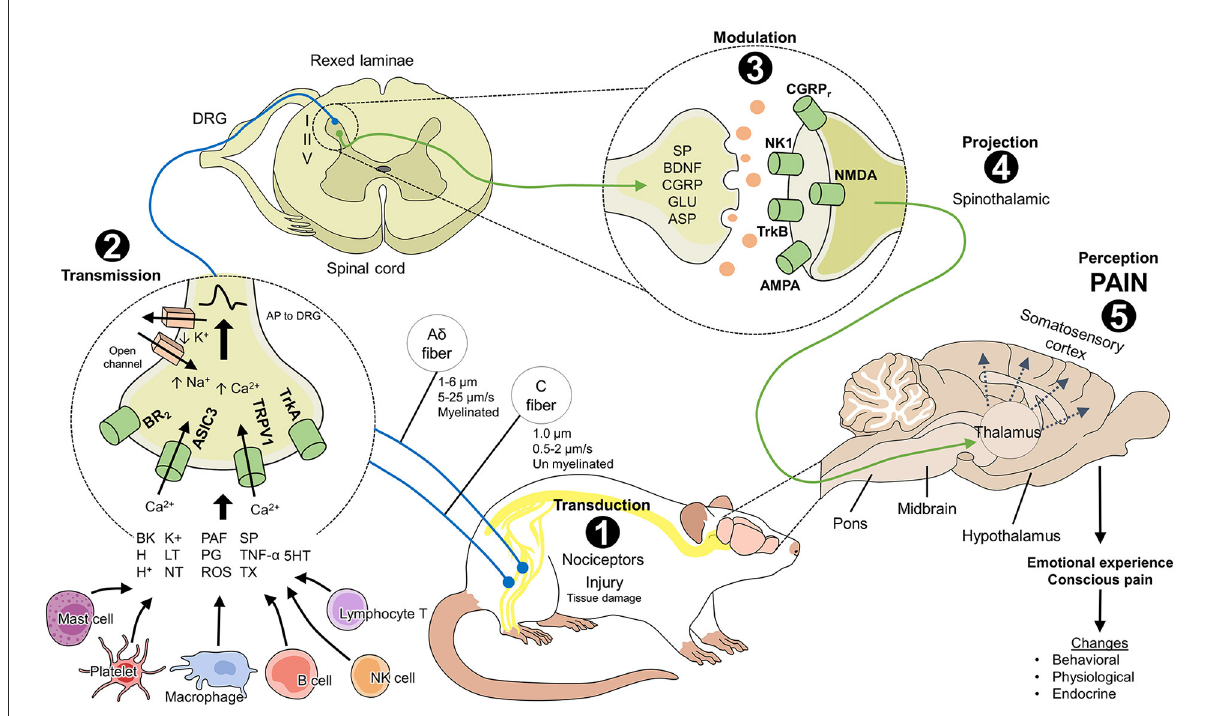
FIGURE1 Neurobiology of pain in laboratory rats ( Rattus norvegicus ). The nociceptive pathway consists of 5 phases that are necessary to perceive pain. 1. Transduction: the transformation of a harmful stimulus into an electrical signal (or action potential) through the action of peripheral receptors (BR2, ASIC3, TRPV1, TrkA) that are activated by inflammatory mediators from mast cells, platelets, macrophages, and tissue damage. 2. Transmission: the action potentials are transmitted to the spinal cord laminae via first-order neurons (marked in blue) where they synapse with second-order neurons (marked in green). Laminae I, II, and V receive nociceptive input from A δ and C fibers. 3. Modulation: the response to harmful stimuli in the inhibitory and excitatory interneurons of the spinal cord can increase or be inhibited depending on the participation of mediators such as SP, BDNF, CGRP, GLU, and ASP and their action on the membrane receptors of the postsynaptic neurons. 4. Projection: second-order neurons project the electrical signal to supraspinal centers through, for example, the spinothalamic tract, which is considered the most important for nociception. 5. Perception: once the signal reaches the higher brain centers, the thalamus connects with neurons in regions like the somatosensory cortex, where the conscious perception of pain and the consequent physiological, endocrine, and behavioral changes in rodents take place. AMPA: α -amino-3-hydroxy-5-methyl-4-isoxazole propionic acid; ASIC3, acid-sensitive ion channel 3; ASP, aspartate; BDNF, brain-derived neurotrophic factor; BK, bradykinin; BR2, bradykinin receptor 2; CGRP, calcitonin gene-related peptide; CGRPr,